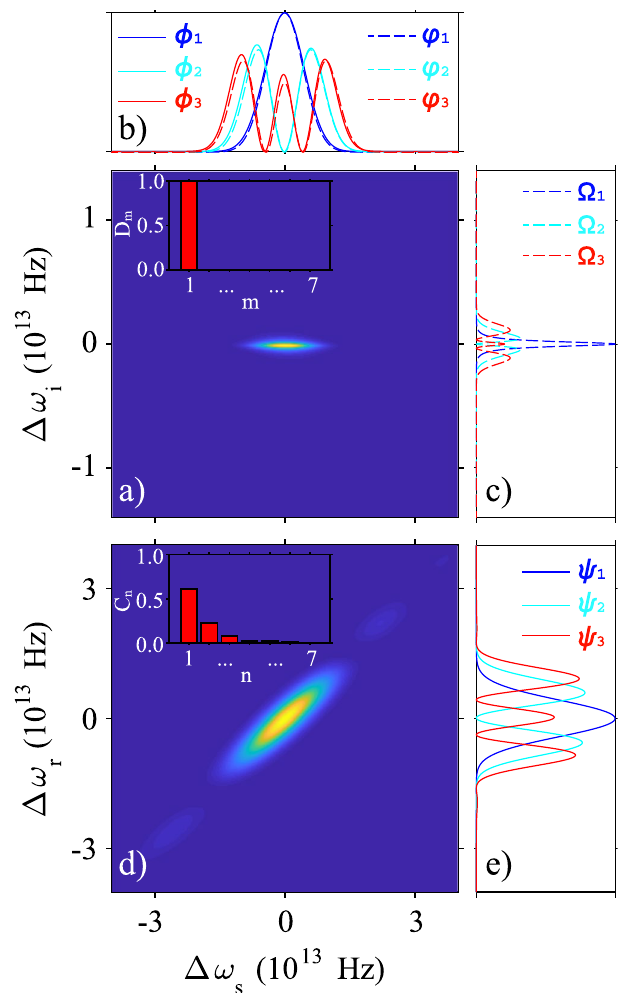
Figure 2. Spectral properties of the proposed SFWM and DFG sources. ( a ) The normalized joint spectral intensity of the SFWM source. ( b ) and ( c ) The three first temporal-mode pairs of the JSA ( ϕ m (ω s ) , � m (ω i ) ), plotted as dashed lines. ( d ) The normalized DFG mapping function. ( b ) and ( e ) The three first temporal-mode pairs of the MF ( φ j (ω s ) , ψ j (ω i ) ), plotted as solid lines. Note that the eigenfunctions have been normalized to the maximum value of the fundamental mode, while the joint spectral functions were normalized to their corresponding maximum value.The insets of panels ( a ) and ( d ) show the Schmidt coefficients of the JSA and MF,